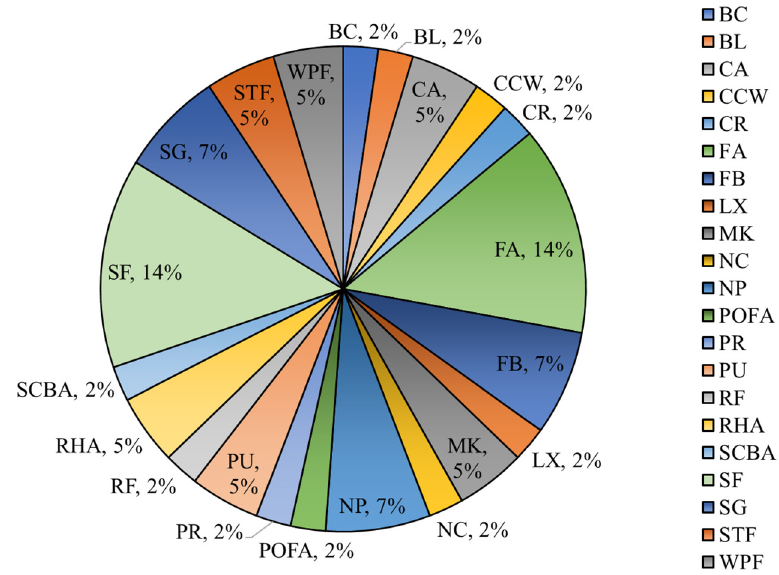
Figure 3. Distribution of materials used as a replacement for cement in the literature.